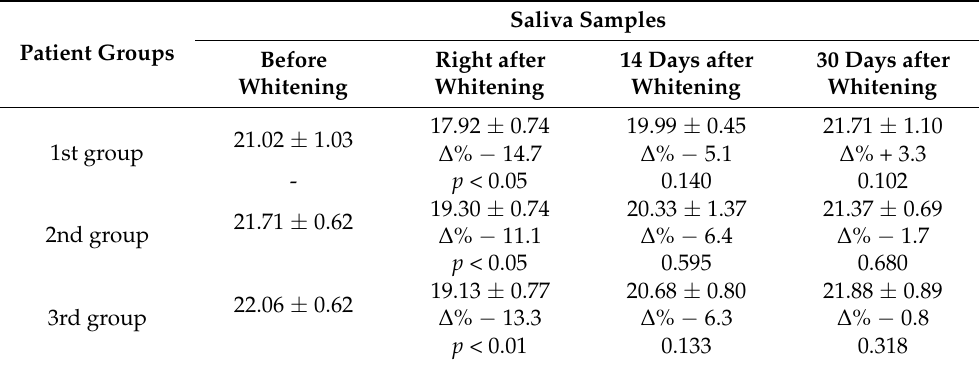
Table 2. The activity of alkaline phosphatase in the oral fluid before and at different times after tooth whitening